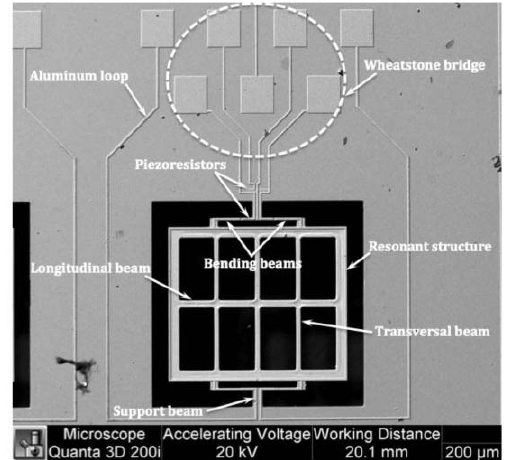
Figure 24. SEM image of a MEMS magnetic field sensor with potential application to obtain a